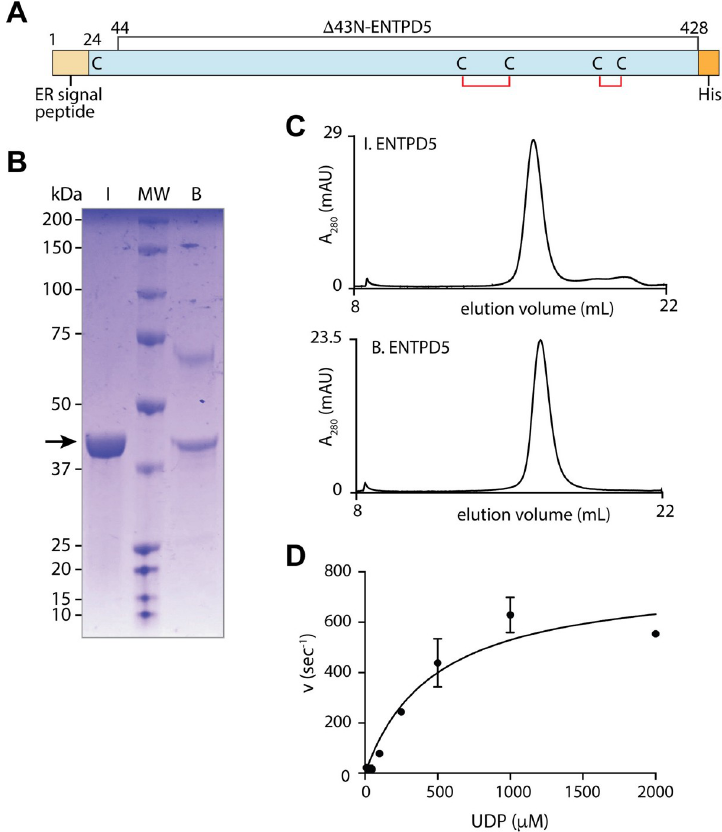
Fig 2. ENTPD5 construct, purification, and activity. A ) Diagram of ENTPD5 construct used for recombinant protein production, highlighting the expected internal disulfide bonds. B ) SDS-PAGE gel of ENTPD5 purified from insect cells (lane I ) and from bacteria (lane B ). Molecular weight marker (lane MW ) sizes in kDa are shown to the left of the gel. BSA, the additional band in lane B at 66 kDa, was added post-purification to stabilize B.ENTPD5. C ) Gel filtration traces of recombinant ENTPD5 proteins. D ) Michaelis-Menten plot of purified I.ENTPD5 activity with substrate UDP using the Malachite Green assay. K m : 480 ± 111 μ M; k cat : 783 ± 68 s -1 . Reactions were performed in triplicate. Error bars designate standard